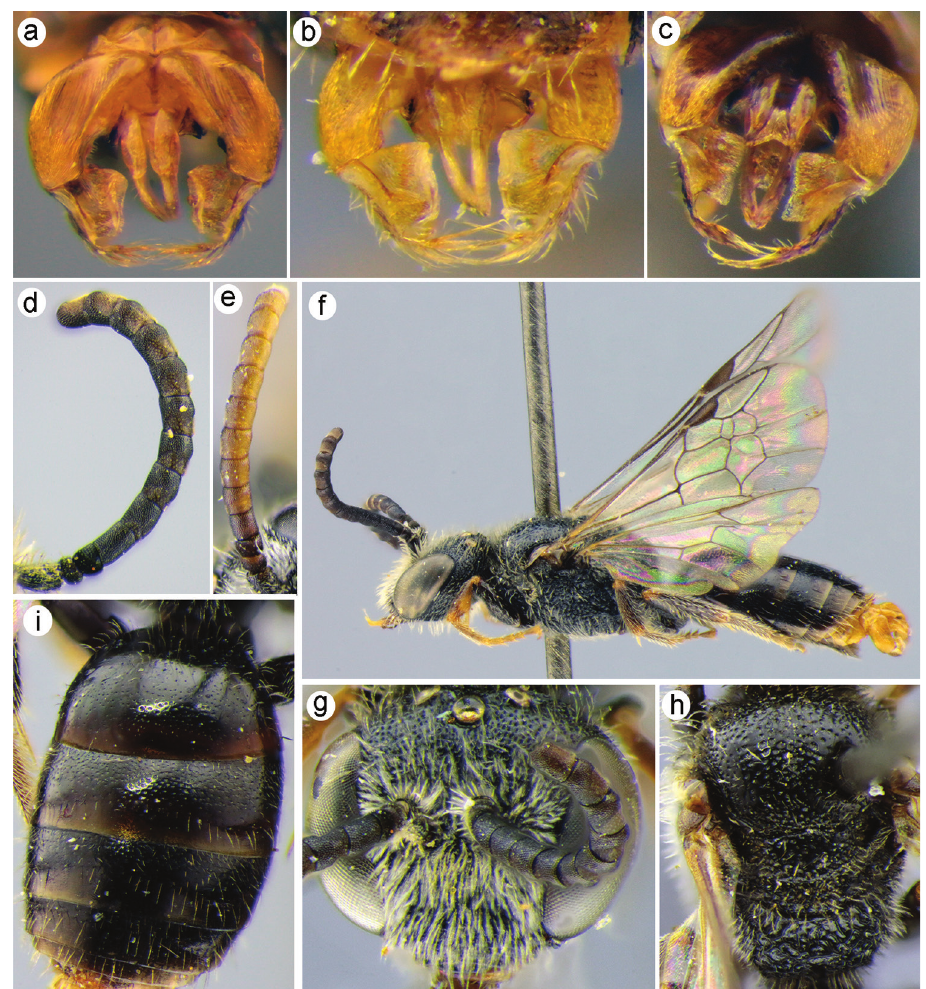
Figure 1. Sphecodes ebmeri Astafurova & Proshchalykin, sp. n., holotype, male ( a, d, f–i ), S. nomioides Pesenko, male ( b, e ), and S. geoffrellus (Kirby), male ( c ): a–c genitalia, dorsal view d, e antennae, lateral view f habitus, lateral view g head, frontal view h mesosoma, dorsal view i metasoma, dorsal view.